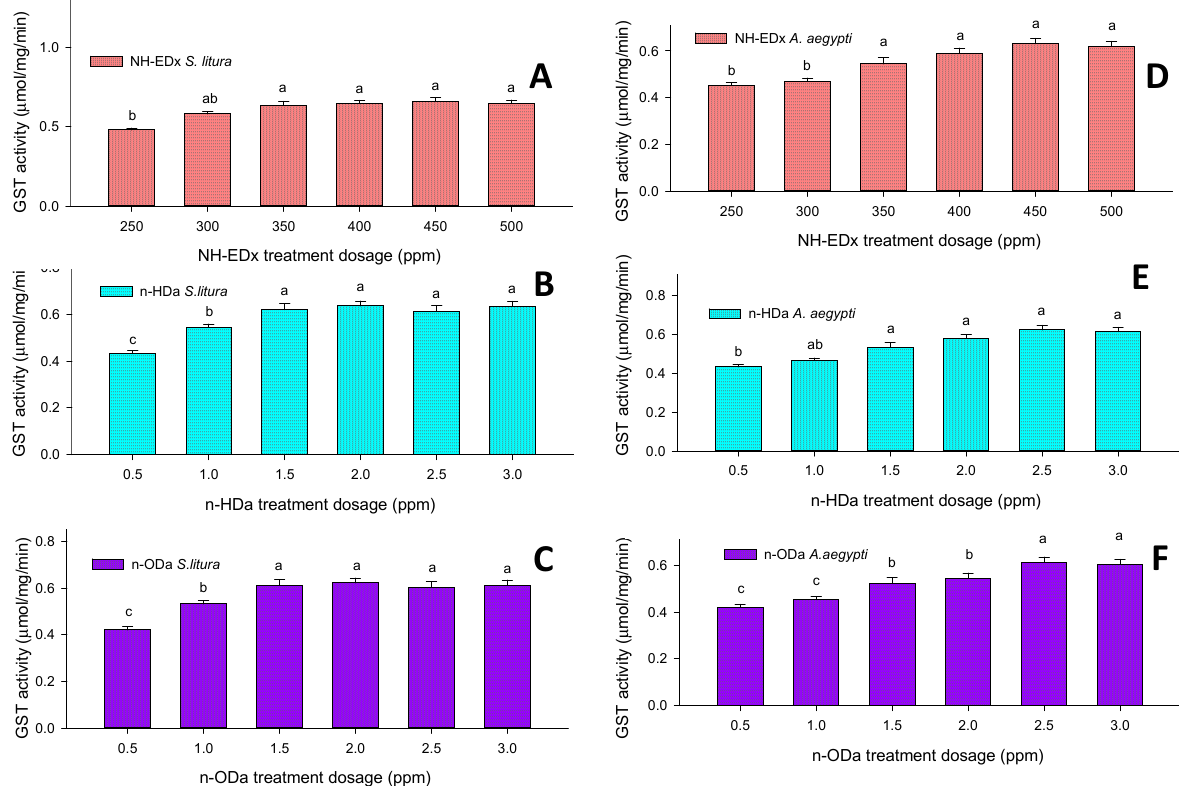
Figure 9. GST enzyme activity of the fourth instars of S. litura after treatment with ( A ) NH-EDx, ( B ) n -HDa, and ( C ) n -ODa and of fourth instars of A. aegypti after treatment with ( D ) NH-EDx, ( E ) n -HDa, and ( F ) n -ODa, respectively. The data were fitted on a polynomial (regression) model. Vertical bars followed by letters indicate standard error (±SEM).